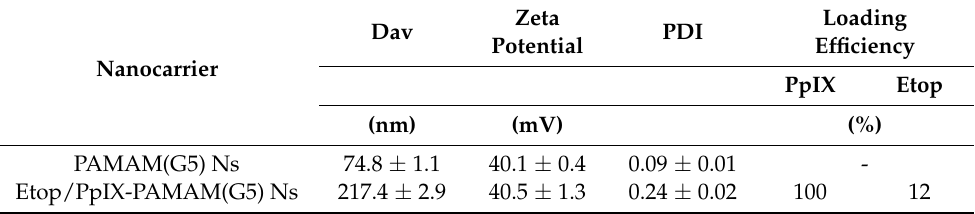
Table 1. Average diameter, zeta potential, polydispersity index, and loading efficiency of the nanocarriers.